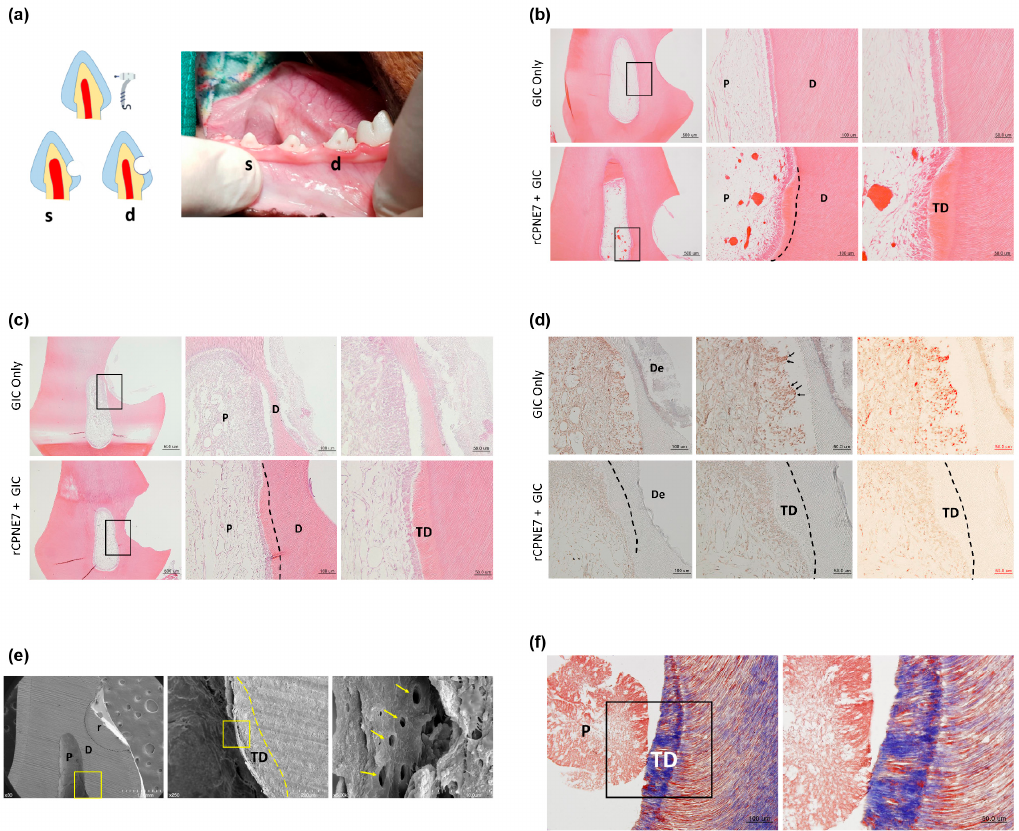
Figure 1. Treatment of rCPNE7 promotes the regeneration of tubular orthodentin in shallow and deep cavity models after three weeks. ( a ) Schematic illustration and representative macroscopic image of s) shallow and d) deep cavity prepared on the cervical areas of beagle dog premolars. ( b ) Histological analysis of dental pulp responses at the shallow cavity preparation areas treated with or without rCPNE7 by hematoxylin and eosin staining ( n = 6). Dashed line indicates the remaining original dentin/newly formed dentin interfaces. ( c ) Histological analysis of dental pulp responses at the deep cavity preparation areas with or without rCPNE7 treatment by hematoxylin and eosin staining ( n = 6). Dashed line indicates the remaining original dentin/newly formed dentin interfaces. ( d ) TUNEL staining of dental pulp at the deep cavity preparation areas with or without rCPNE7 treatment. ( e ) Scanning electron microscope images of the rCPNE7-treated group. Boxed areas indicate the dentin–pulp interface in the newly formed dentin. Arrows indicate the dentinal tubules; dashed line indicates the remaining original dentin/newly formed dentin interfaces. ( f ) Masson’s trichrome staining of newly formed dentin in rCPNE7-treated group. P, pulp; D, dentin; TD, newly formed tertiary dentin; De, defect; r, resin composite.